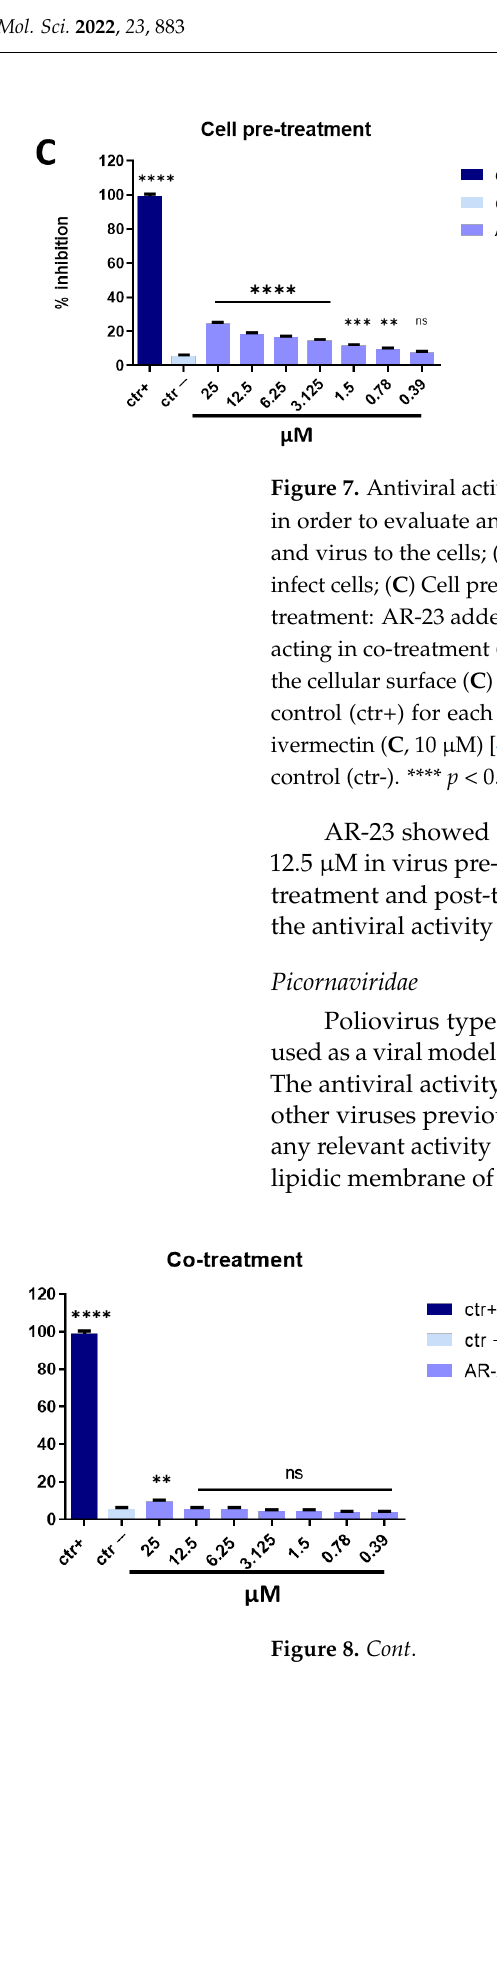
Figur e 8. Antiviral activity against PV-1. Different assays were performed in order to evaluate an- ti-PV-1 activity. ( A ) Co-treatment: simultaneous addition of AR-23 and virus to the cells; ( B ) Virus pre-treatment: virus incubated with the peptide, and then used to infect cells; ( C ) Cell pre-treatment: AR-23 incubated with the cells before the viral infection; ( D ) Post-treatment: AR-23 added to the infected cells. Peptide AR-23 inhibited the early stages of infection, acting in co-treatment ( A ) and virus pre-treatment ( B ) assays, while it was not able to interact with the cel- lular surface ( C ) or block the viral replication ( D ). Different compounds were used as positive control (ctr+) for each treatment: pleconaril ( A , B , 2 μ g/mL for both the assays) [46] , WIN51711 ( C , 5 μ g/mL) [45] , and protein 2C (D, 10 μ M) [47] , while infected cells were used as negative control (ctr-). **** p < 0.0001; ** p < 0.0021; * p < 0.021; ns: non-significant. 2.3. Molecular Assay: Real-Time PCR To confirm data obtained in cell culture through plaque assays, a molecular test was carried out. Expression of genes involved in the viral infection was analyzed, in detail UL54, UL27, and UL52 genes for DNA virus (HSV-1), and Spike gene (S) and Nucle- ocapsid gene (N) for RNA viruses (HCoV-229E and SARS-CoV-2). In detail, UL54 is an immediate early gene encoding for the ICP27 protein involved in HSV-1 replication, by inhibiting mRNA splicing at the post-transcriptional level and promoting the export of viral transcripts; UL52 is an early gene codifying for DNA primase, and UL27 gene rep- resents a late gene coding for the structural glycoprotein B (gB) [48]. Virus pre-treatment assay was performed, RNA was collected after 24 h, retro-transcribed into cDNA and amplified by real-time PCR. Data showed that AR-23 interfered with HSV-1 replication by significantly reducing the expression of all three genes (Figure 9A); by decreasing the peptide concentration, viral gene expression increased and reached the same level of vi- rus control at the concentration of 0.39 μM. Antiviral activity of the peptide was investi- gated against HCoV-229E and SARS-CoV-2, analyzing the expression of proteins in- volved in the entry of the virus in the cell (S protein), and the viral genome packaging (N protein) [49]. Results showed that the infection was reduced in a dose-dependent manner for both tested viruses (Figure 9B,C).